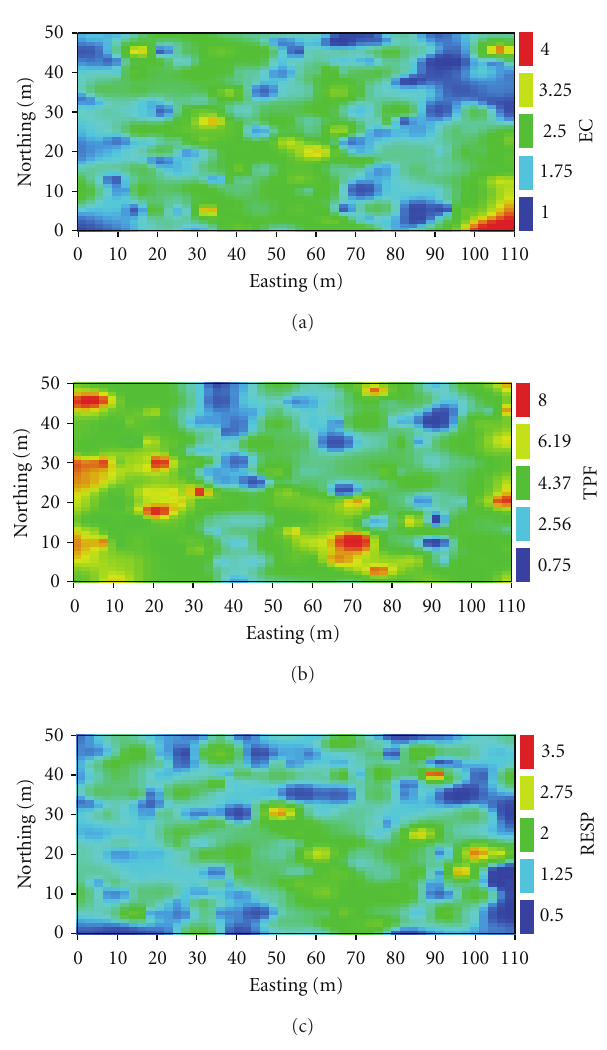
Figure 1: Interpolated spatial maps, over the 110 by 50 m field, of electrical conductivity (EC), dehydrogenase (TPF), and microbial respiration (RESP). Units are the same as Table